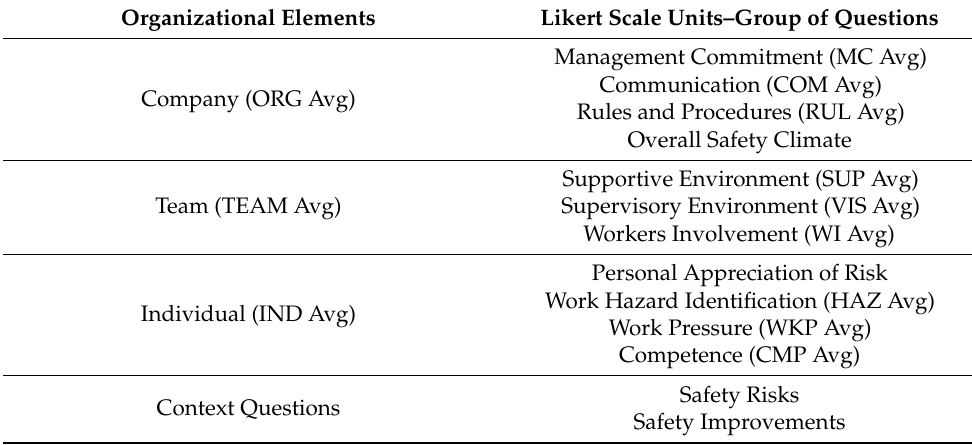
Table 2. Structure of Safety Perception Survey. Organizational Elements Likert Scale Units–Group of